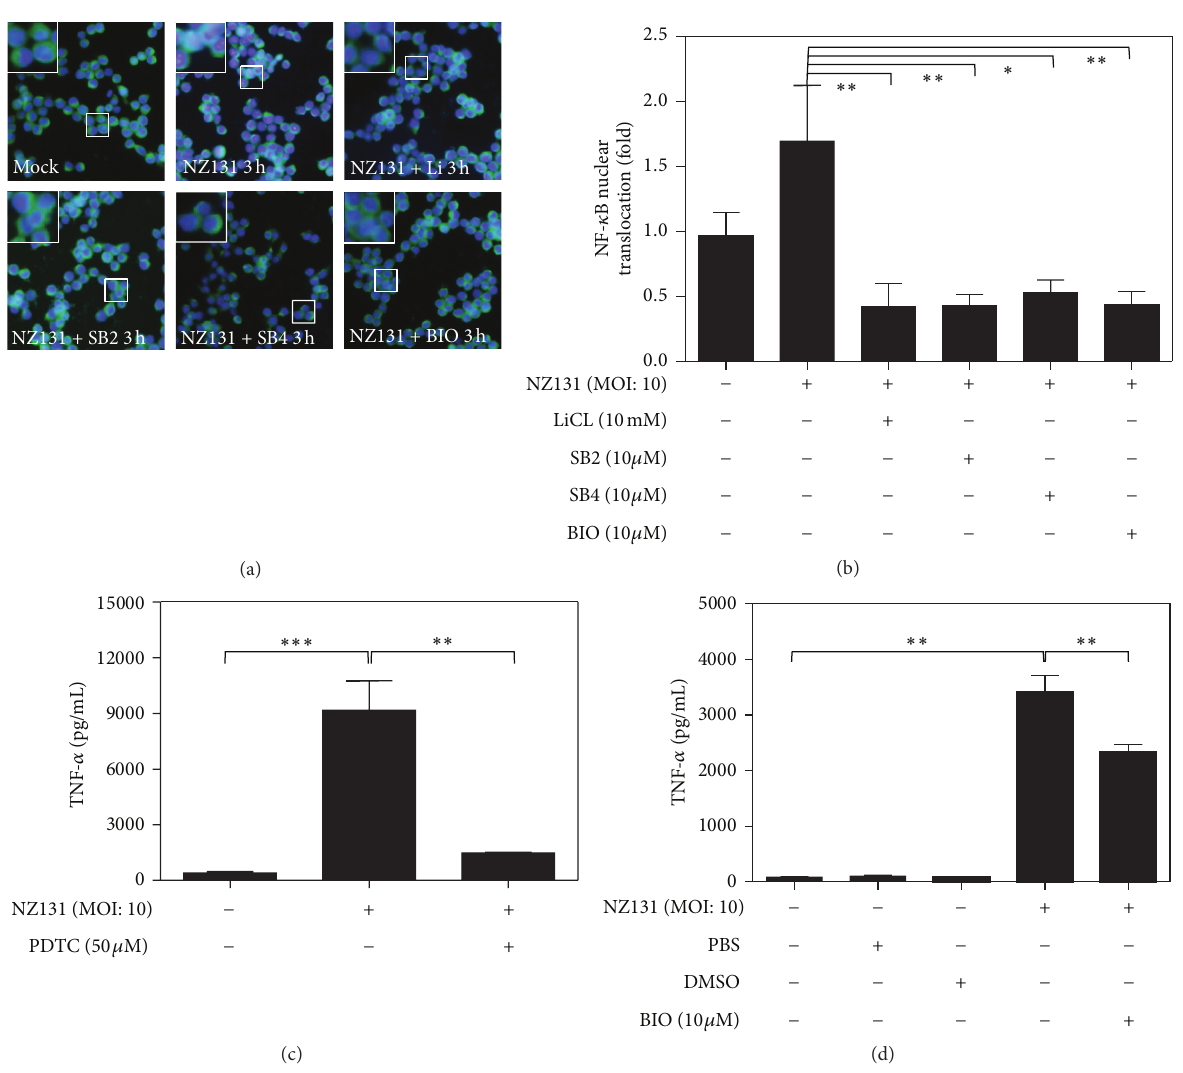
Figure 3: Inhibition of GSK-3 𝛽 downregulates NF- 𝜅 B nuclear translocation and proinflammatory cytokine TNF- 𝛼 production in macrophages after stimulation by NZ131. (a) Immunocytochemical staining for NF- 𝜅 B p65 and DAPI for nuclear staining were used to determine the nuclear translocation of NF- 𝜅 B in RAW 264.7 cells (2 × 10 5 cells/well in 24-well culture plate) 3 h after NZ131 infection (MOI: 10). Representative fields of NF- 𝜅 B translocation in RAW 264.7 cells are shown. (b) The bar chart graph is the summary of (a) for the ratio of the change of NF- 𝜅 B nuclear translocation after NZ131 infection and pretreatment with various GSK-3 𝛽 inhibitors (LiCl, SB2, SB4, and BIO). The data for each treated or untreated group is the average result calculated by six randomly selected fields in one experiment. ((c) and (d)) The concentrations of TNF- 𝛼 in RAW 264.7 cell culture supernatant 24 h after NZ131 stimulation and pretreatment with NF- 𝜅 B inhibitor (PDTC) or GSK-3 𝛽 inhibitor (BIO) were